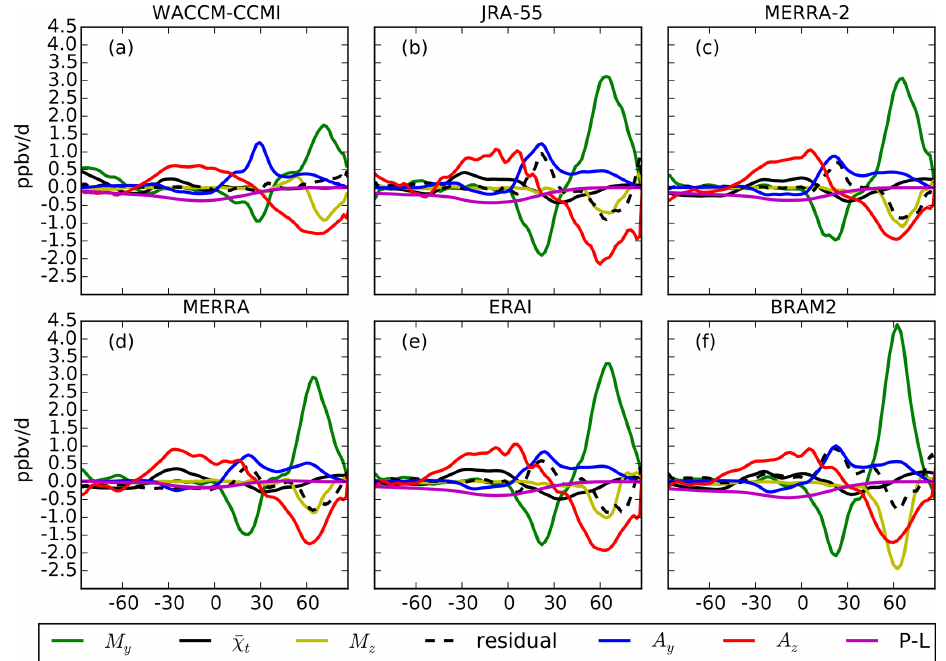
Figure 1. Latitudinal profiles of the N 2 O TEM budget terms at 15hPa averaged in DJF (2005–2014) with WACCM-CCMI (a) , JRA-55 (b) , MERRA-2 (c) , MERRA (d) , ERAI (e) and BRAM2 (f) . The color code is shown in the legend. Units are in parts per billion by volume per day (ppbvd − 1 ).